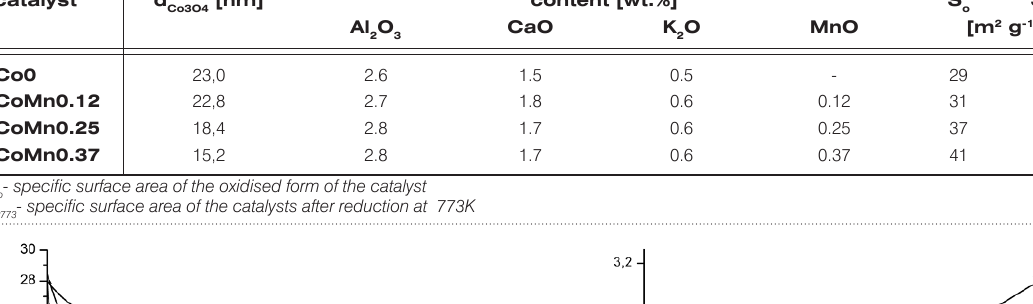
Table 1. Characteristics of the prepared catalysts. catalyst